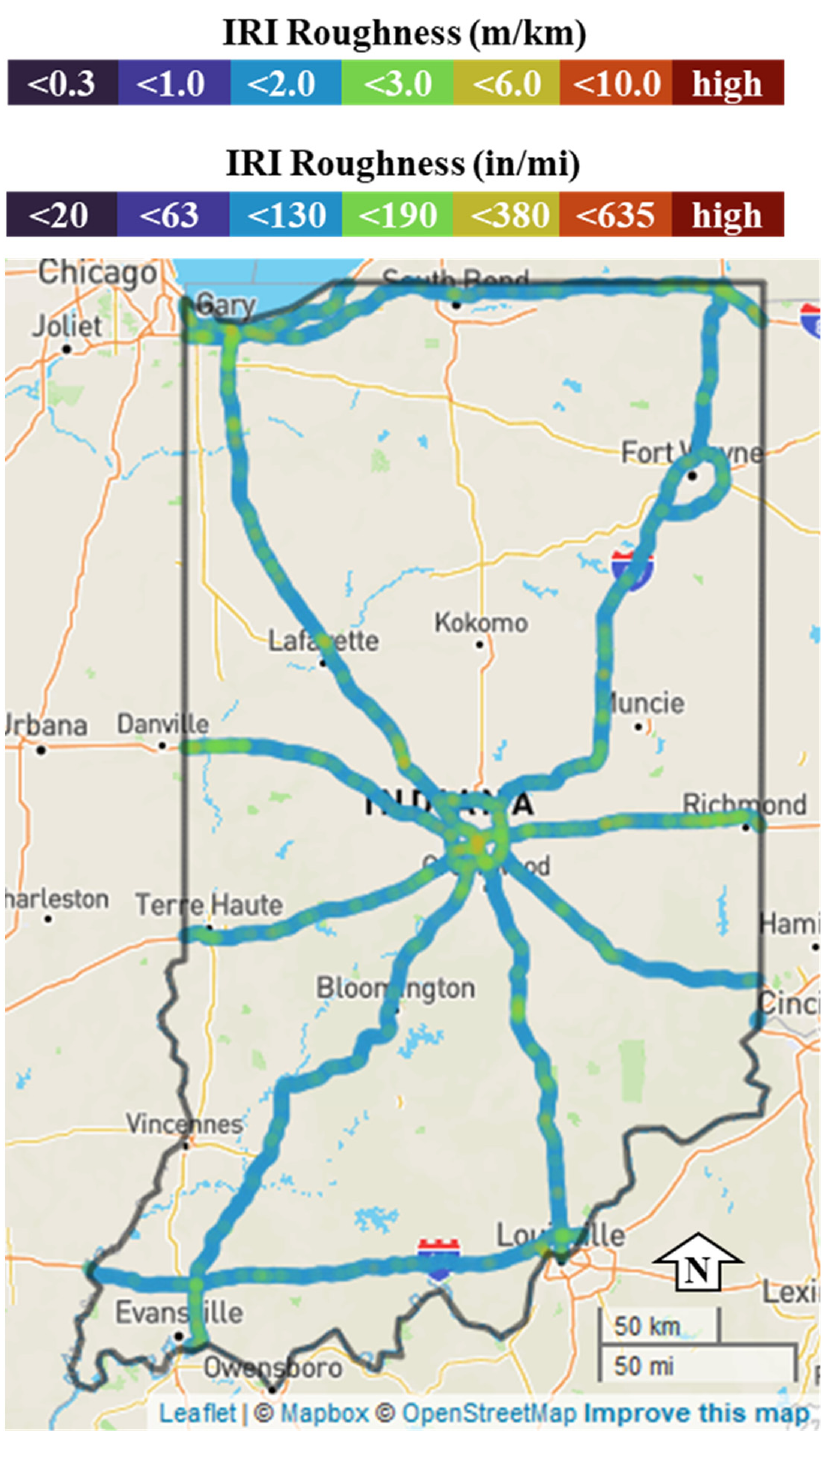
Figure 14. Statewide pavement roughness.